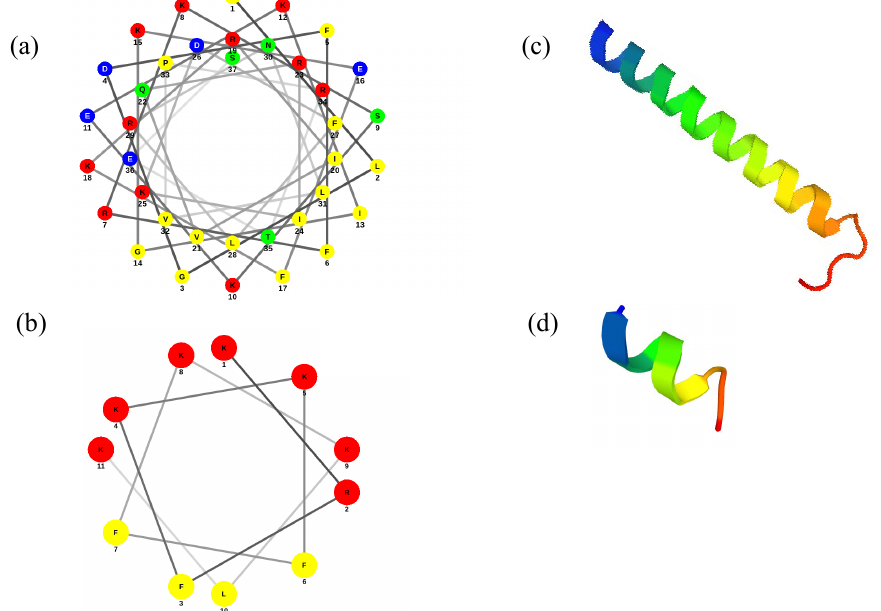
Figure 1. Prediction of helical structure for ( a ) LL-37 and ( b ) ATRA-1. Polar residues are represented as: basic in red, acid in blue, and uncharged in green: Non-polar residues are represented in yellow. Three-dimensional structures of ( c ) LL-37 and ( d ) ATRA-1.